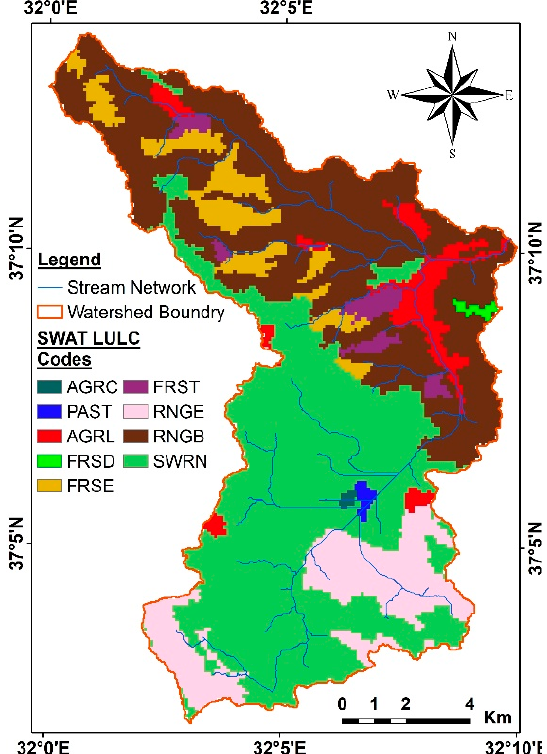
Figure 2. Land use/land cover (LULC) map of the study area. Figure 2. Land use / land cover (LULC) map of the study area.